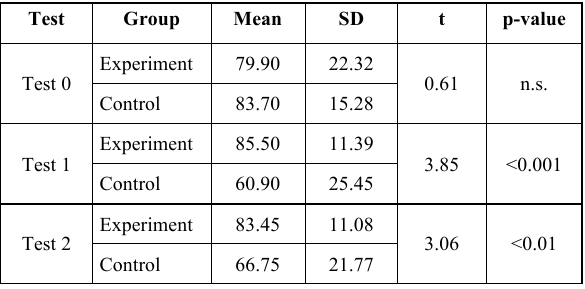
TABLE I. A CHIEVEMENT T ESTS : S CORES